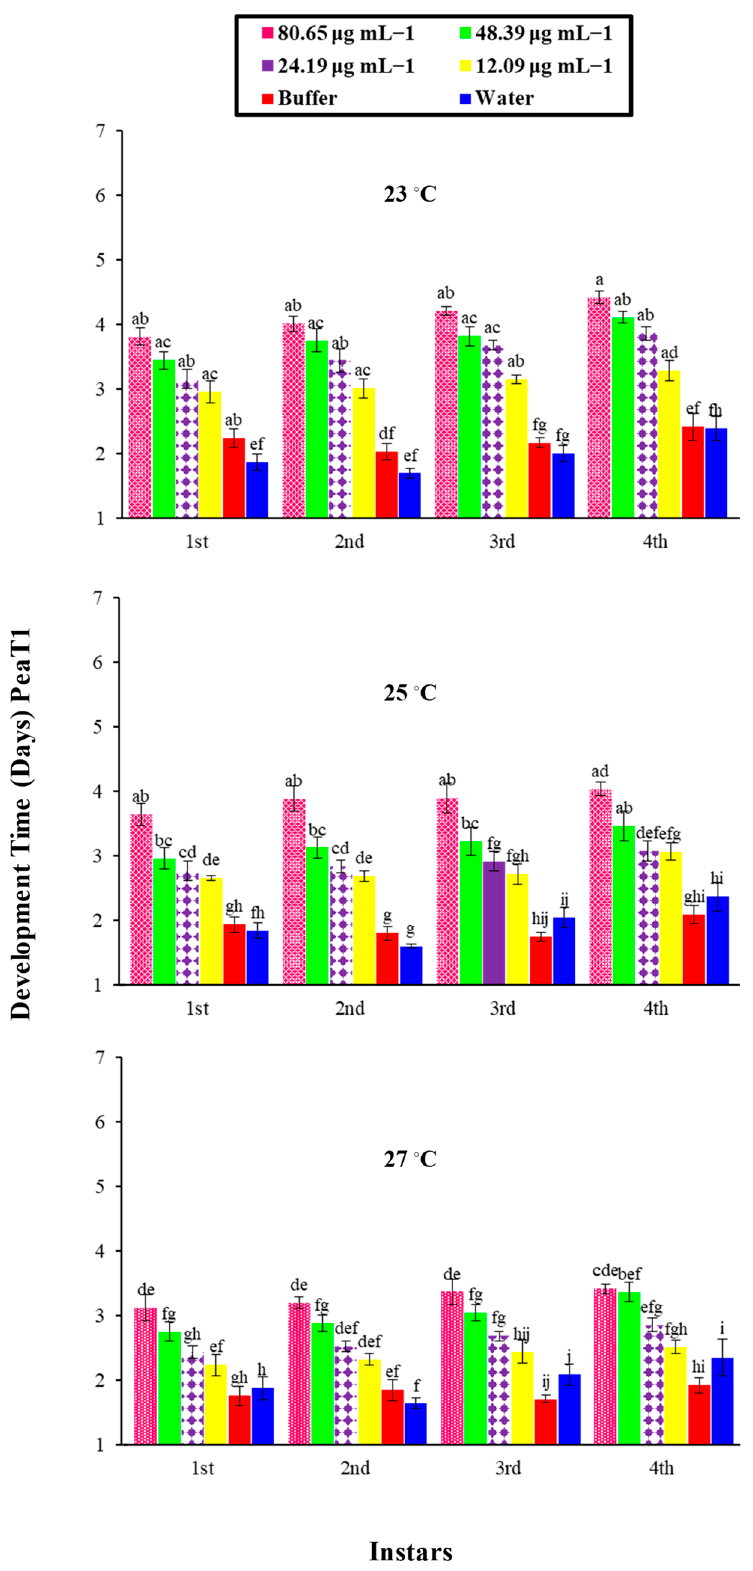
Figure 3. Mean developmental time, ( ± SE) of different nymphal instars of M. persicae on chili plants by PeaT1 elicitor protein at different concentrations and different temperature (23, 25, 27 °C) regimes ( n = 10). Different alphabets above bar tops specify significant differences between treatments (factorial analysis one way ANOVA; LSD at α = 0.05).